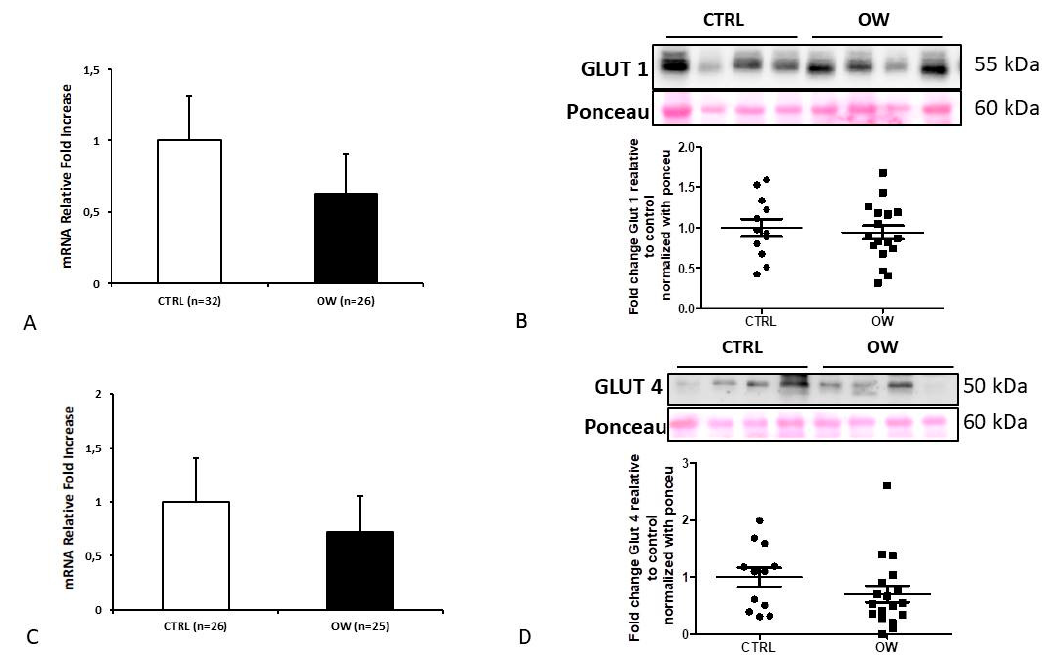
Figure 1. Glut 1 and 4 expression ( A , C ) and protein levels ( B , D ) in placenta from normal ( CTRL ) and overweight ( OW ) women. ( A ) qPCR analysis of GLUT1 mRNA in normal ( n = 32) and overweight ( n = 26) placental tissue. ( B ) Representative WB (high panel) and corresponding densitometry (low panel) of GLUT1 in placenta from CTRL ( n = 12) and OW ( n = 18) women. ( C ) qPCR analysis of GLUT4 mRNA in normal ( n = 26) and overweight ( n = 25) placental tissue. ( D ) Representative WB (high panel) and corresponding densitometry (low panel) of GLUT4 in placenta from CTRL ( n = 12) and OW ( n = 18) women. Data are presented as mean ±ES.